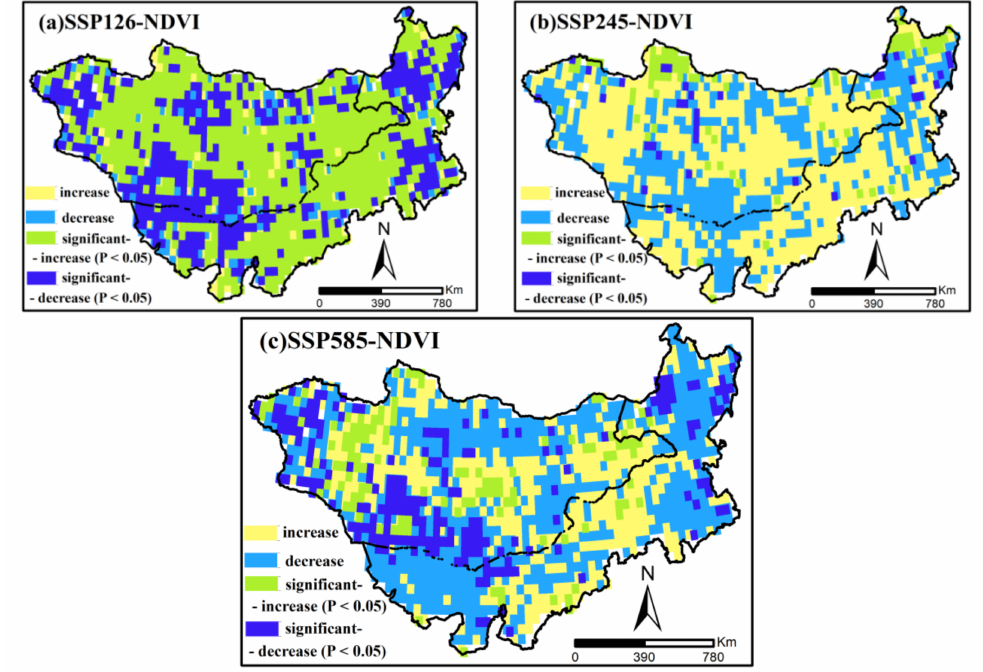
Figure 14. Spatial variation in NDVI on the Mongolian Plateau from 2021 to 2080.(( a – c ): Spatial trends of NDVI in SSP126/SSP248/SSP585 scenarios from 2012 to